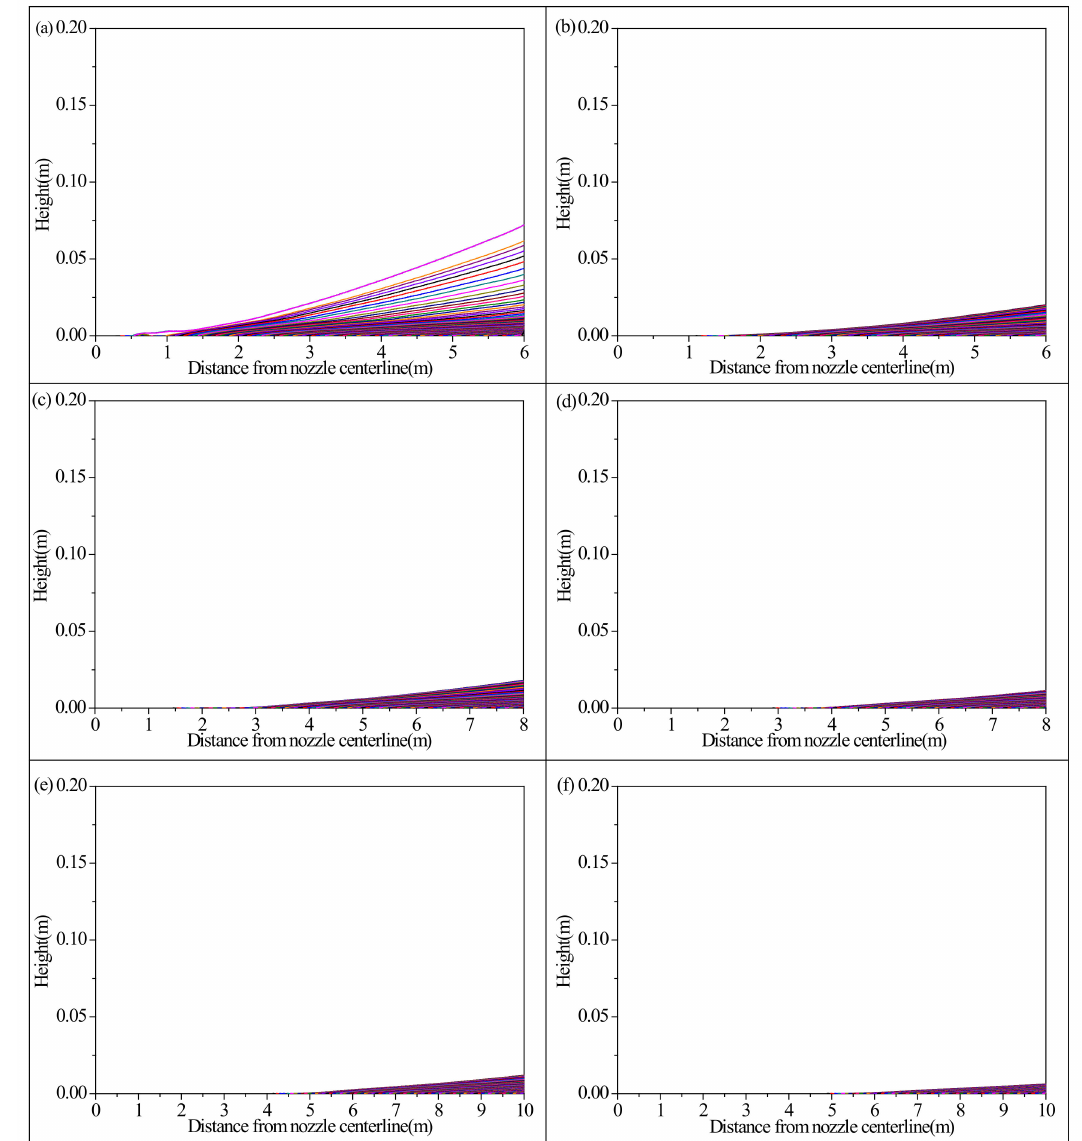
Figure 8. The lunar dust particle trajectories at different nozzle altitudes: ( a ) H = 1.54 m, ( b ) H = 5.80 m, ( c ) H = 7.83 m, ( d ) H = 9.82 m, ( e ) H = 11.83 m, and ( f ) H = 13.74